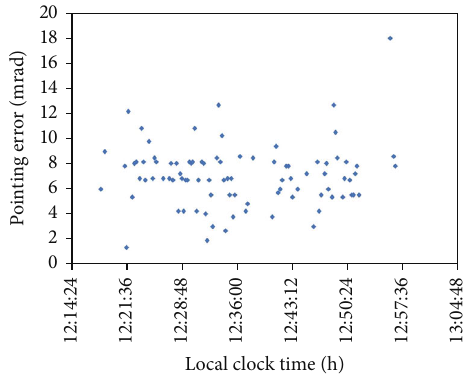
Figure 15: Measurement result of pointing error for prototype mobile sun-tracking system under stationary condition on 13 th April.